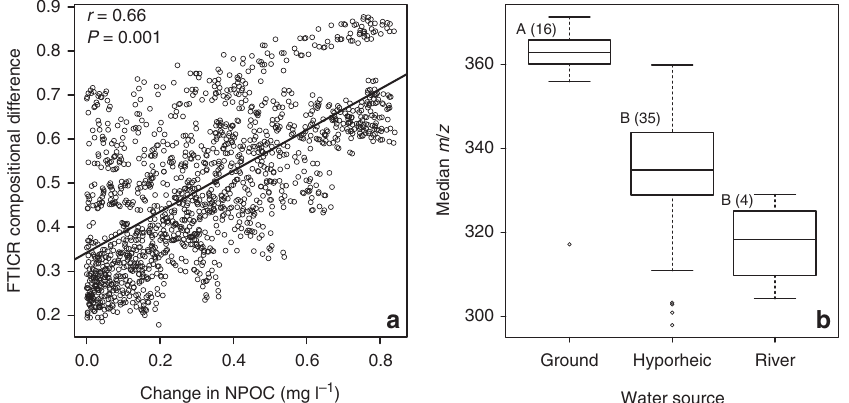
Figure 4 | Variation in FT–ICR MS-based dissolved organic carbon composition. ( a ) Change in carbon composition—measured as Sorensen dissimilarity, bounded between 0 and 1—as a function of change in NPOC concentration. The solid line indicates the regression model and associated Mantel test statistics are provided. ( b ) Box plots summarizing distributions of mass-to-charge ratios ( m / z ) across different water sources. Different letters indicate statistically significant differences ( P o 0.05) by a Kruskal–Wallis test and values in parantheses are the number of samples in each group.